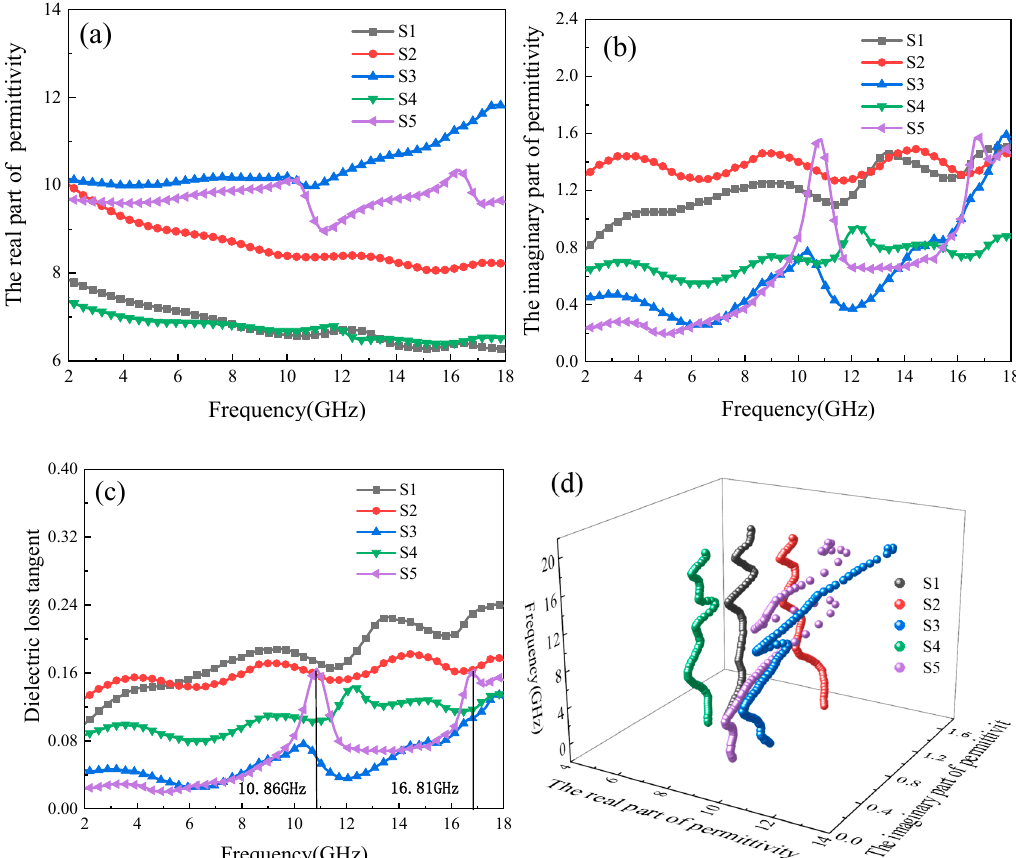
Figure 4. ( a ) The real part of permittivity, ( b ) the imaginary part of permittivity, ( c ) dielectric loss tangent, and ( d ) Cole-Cole curves of Fe 3 O 4 in the range of 2–18 GHz. (cid:48) The dielectric loss tangent (tan δ E = ε ” / ε ) reflects the dielectric loss ability of material. Tan δ E of (cid:48) Fe 3 O 4 samples at di ff erent time are shown in Figure 4c. ε changes gently with frequency; the trend of tan δ E is similar to ε ”. Tan δ E decreases with the prolongation of reaction time (S1–S3) before